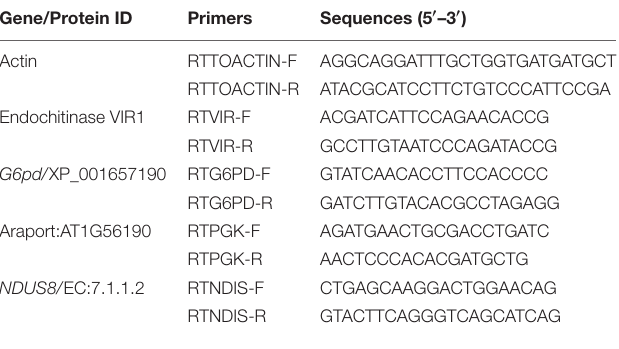
TABLE 1 | Primers used in qRT-PCR assay to assess the expressions of defense genes in tomato induced by the biocontrol treatments on challenge